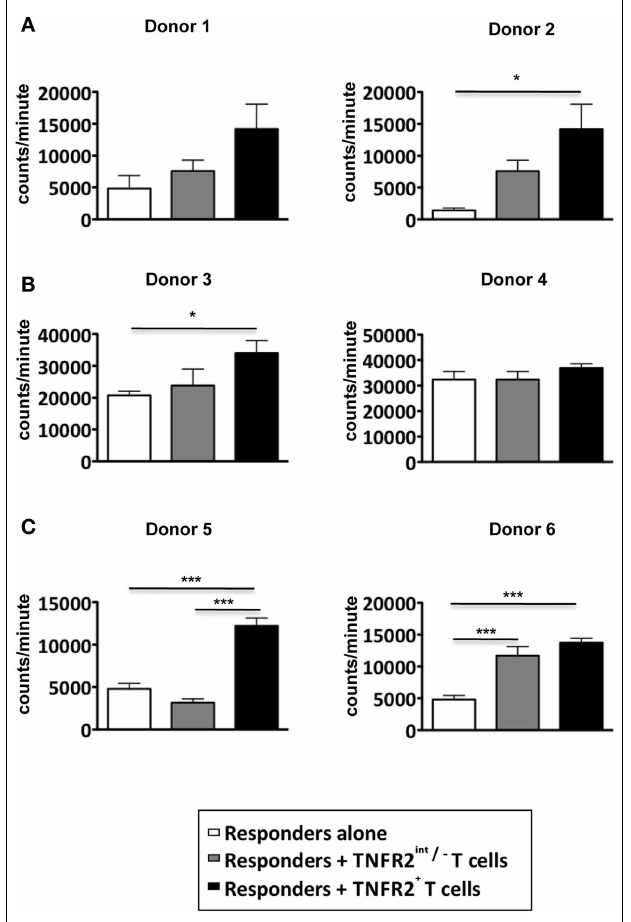
FIGURE 3 | Suppressive capacity of inducedTNFR2 + T cells . CD4 + T cells were stimulated with anti-CD3/28 for 72h. On day 3, induced CD25 int TNFR2 int/ − and CD25 hi TNFR2 + were sorted by flow cytometry and added to autologous responders (CD4 + T cells) at a ratio of 1:1 and stimulated with anti-CD3/28 for 72h in the (A) absence of APCs or (B) presence of APCs. (C) Suppression assays performed using MLRs as responders. PBMCs of three different donors were isolated and cultured together with the indicatedTNFR2 subsets at a 1:1 ratio. One-way ANOVA withTukey’s multiple comparison test was used for (A,C) , and Kruskal–Wallis with Dunn’s multiple comparison test was used for (B) . Error bars indicate SD for (A,B) and SEM for (C) . Comparison of the proliferation of responders: * p < 0.05; *** p <